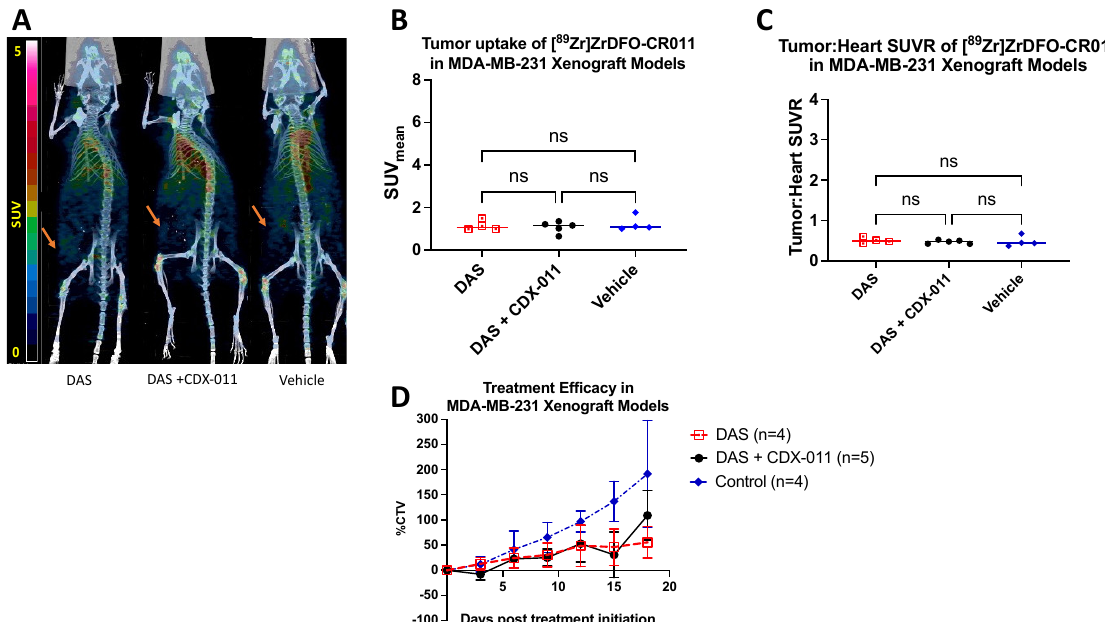
Figure 6. Dasatinib does not significantly affect [ 89 Zr]Zr-DFO-CR011 uptake in MDA-MB-231 xenografted tumors at 21 days post treatment initiation (ns, p > 0.05). ( A ) Representative PET/CT images rendered as maximum intensity projections from each treatment group. Arrows point to tumor. RapID ear tags are shown as white squares. ( B ) Quantification of [ 89 Zr]Zr-DFO-CR011 uptake in the tumor as SUV mean and ( C ) Tumor-to-Heart SUVR after treatment (n = 4–5 per group). ( D ) Change in tumor size measured as the percentage of change in tumor volume (% CTV) relative to baseline after treatment initiation (n = 4–5 per group). DAS = dasatinib. Dasatinib treatment reduced tumor volume but not in a statistically significant way compared with those treated with vehicle control or combination of CDX-011 and dasatinib during the 21-day treatment period ( p > 0.05).